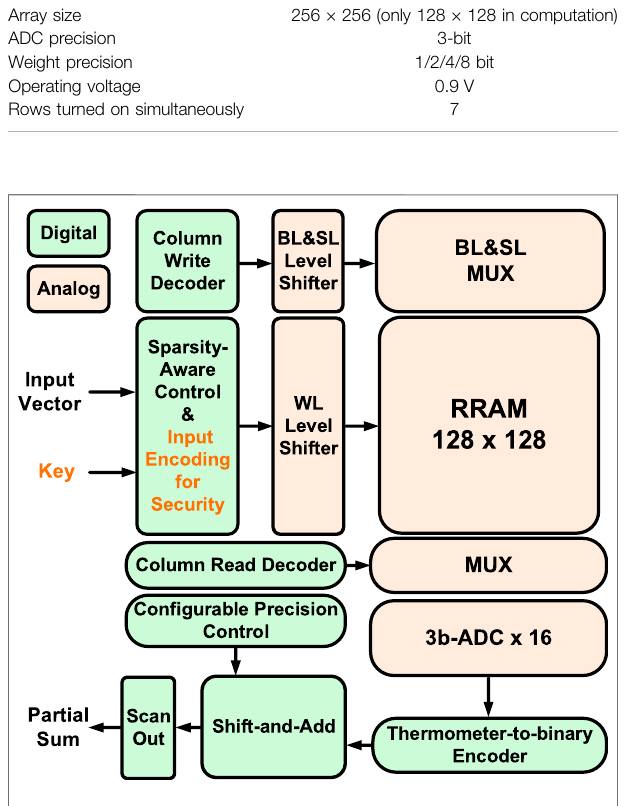
FIGURE 6 | RRAM CIM macro organization that supports input zero- skip and recon fi gurable weight precision. ©2021 IEEE. Reprinted, with permission, from Li et al., 2021.